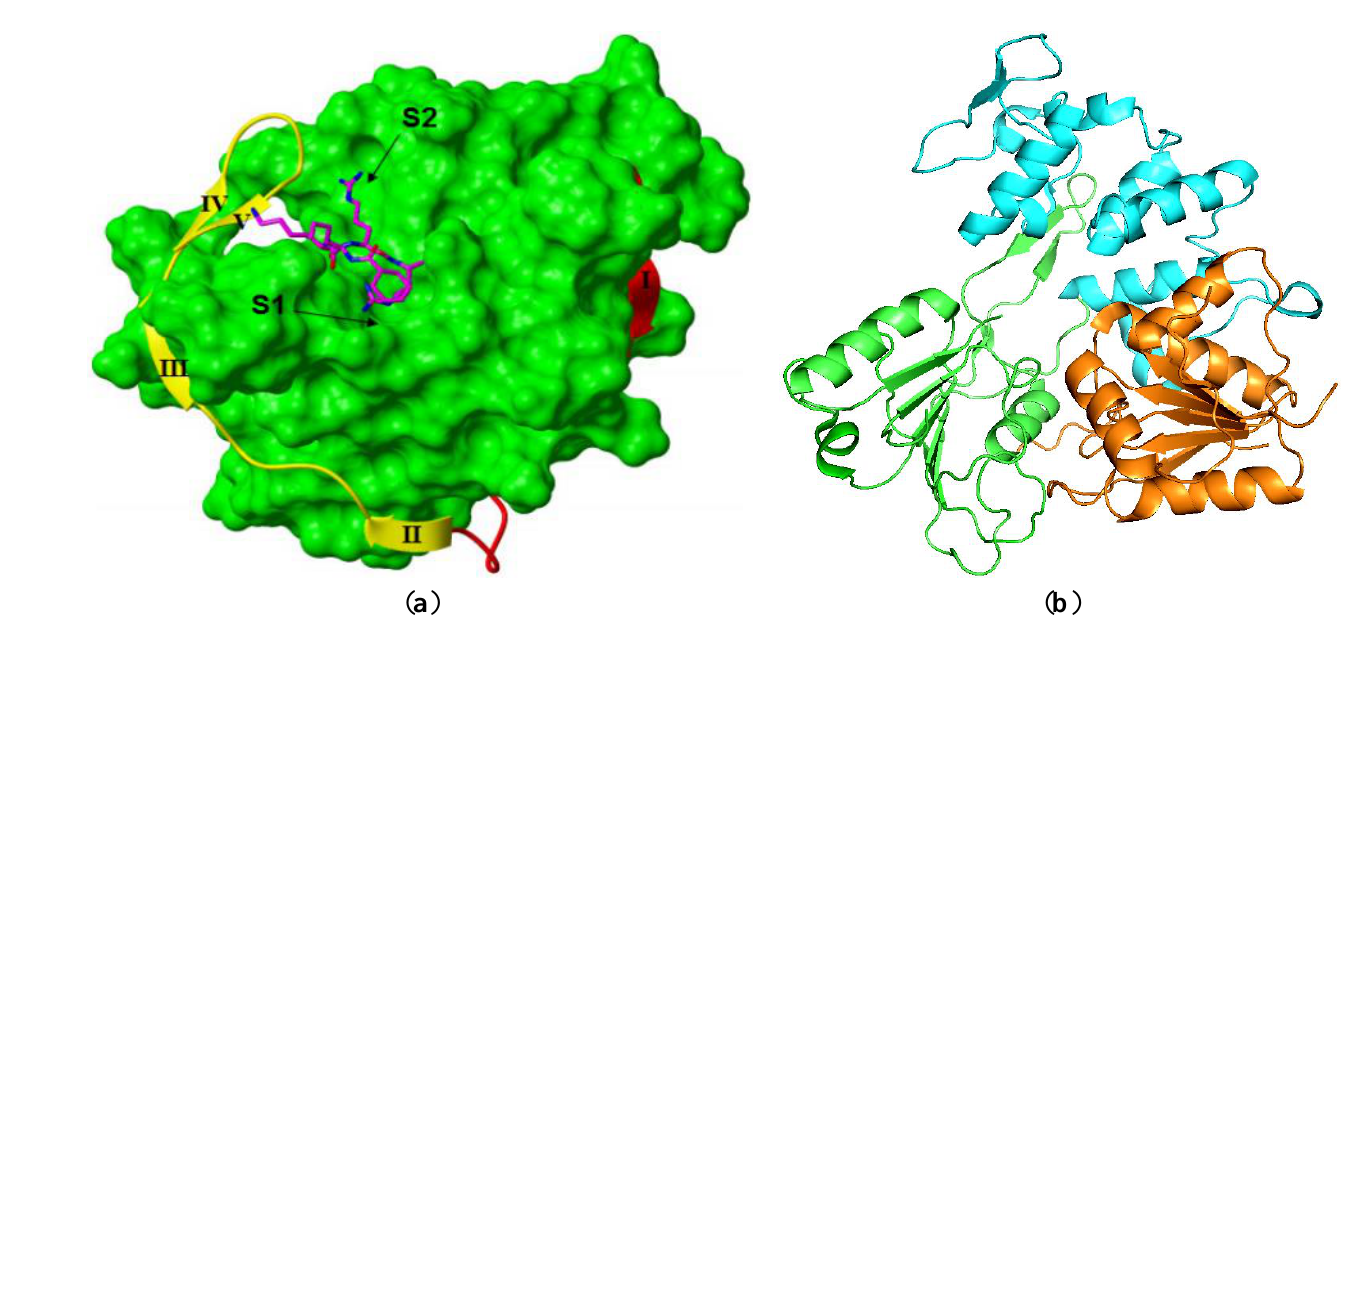
Figure 1. Crystal structures of West Nile Virus (WNV) NS2/NS3 protease and NS3 helicase domains depicted in cartoon representation. ( a ) WNV NS2B/3 protease bound to the peptidic inhibtor, nKRR-H inhibitor [PDB code 2FP7; 39]. NS3 is colored green. NS2B is shown in red ( N -terminal region) and yellow ( C -terminal region). Bz-nKRR-H (pink) is shown in stick representation. Locations of S1 and S2 pockets are marked with arrows; ( b ) WNV NS3 helicase with domains 1, 2 and 3 colored in cyan, green and orange, respectively [PDB code 2QEQ;